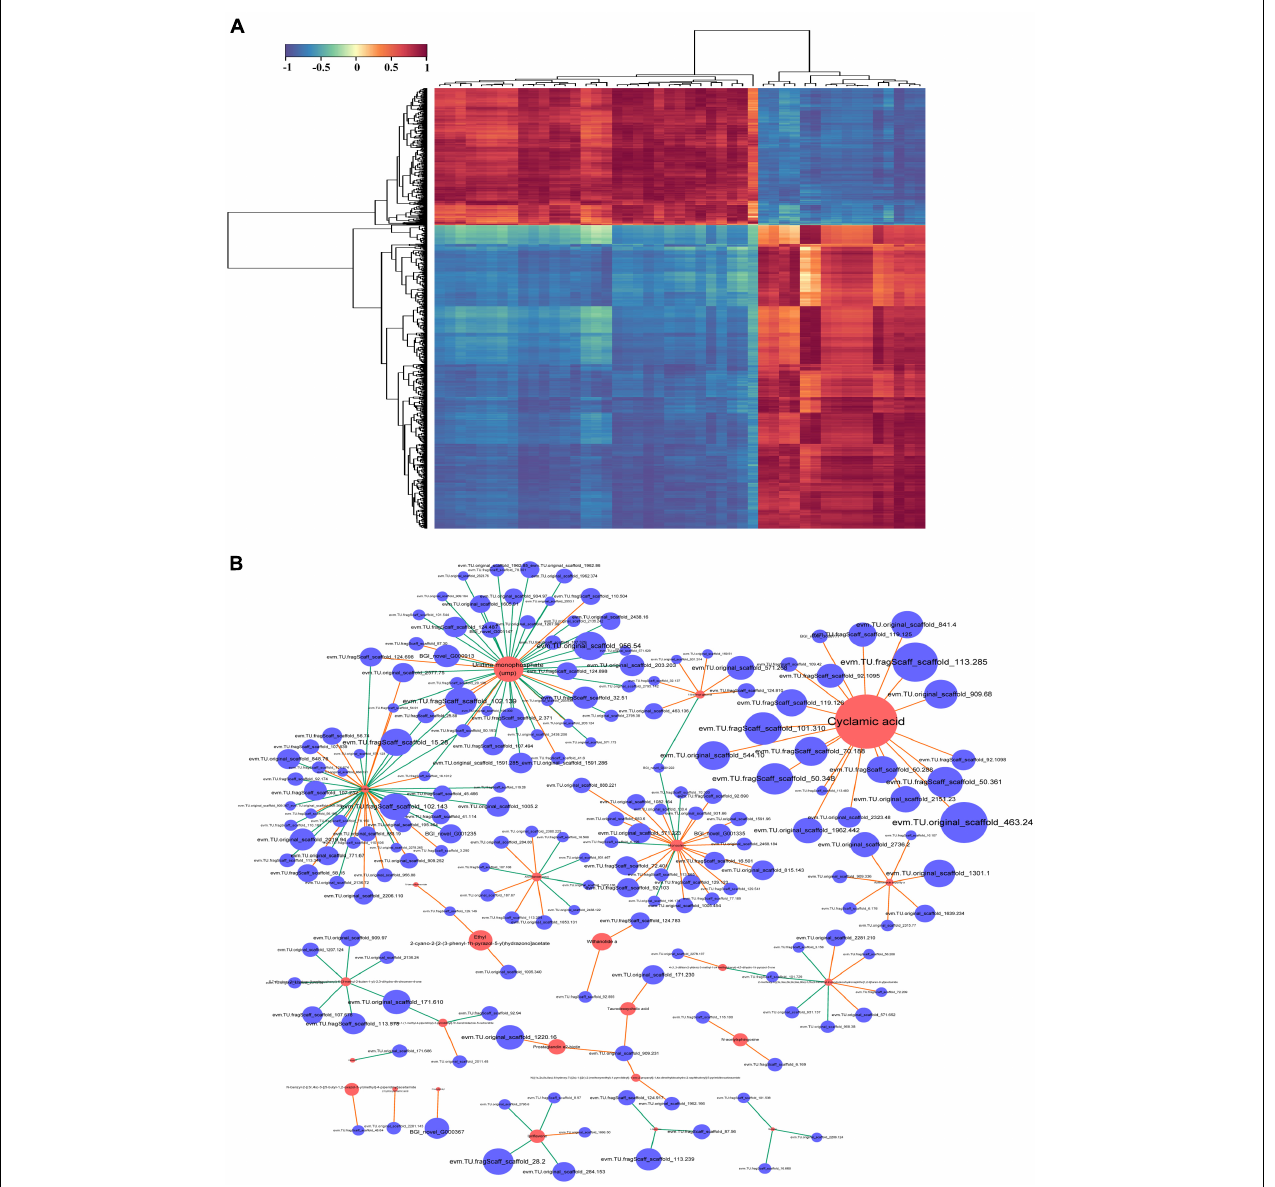
FIGURE 9 | Correlation analysis of differentially expressed metabolites and transcripts. (A) Heatmap of differentially accumulated DEGs and significantly changed metabolites (SCMs). (B) Network of the 182 DEGs and 24 metabolites with strong correlations. Red circles represent metabolites, blue circles represent genes, and edges represent their relationships. Red and green edges represent positive and negative correlations, respectively, with a Pearson correlation coefficient >